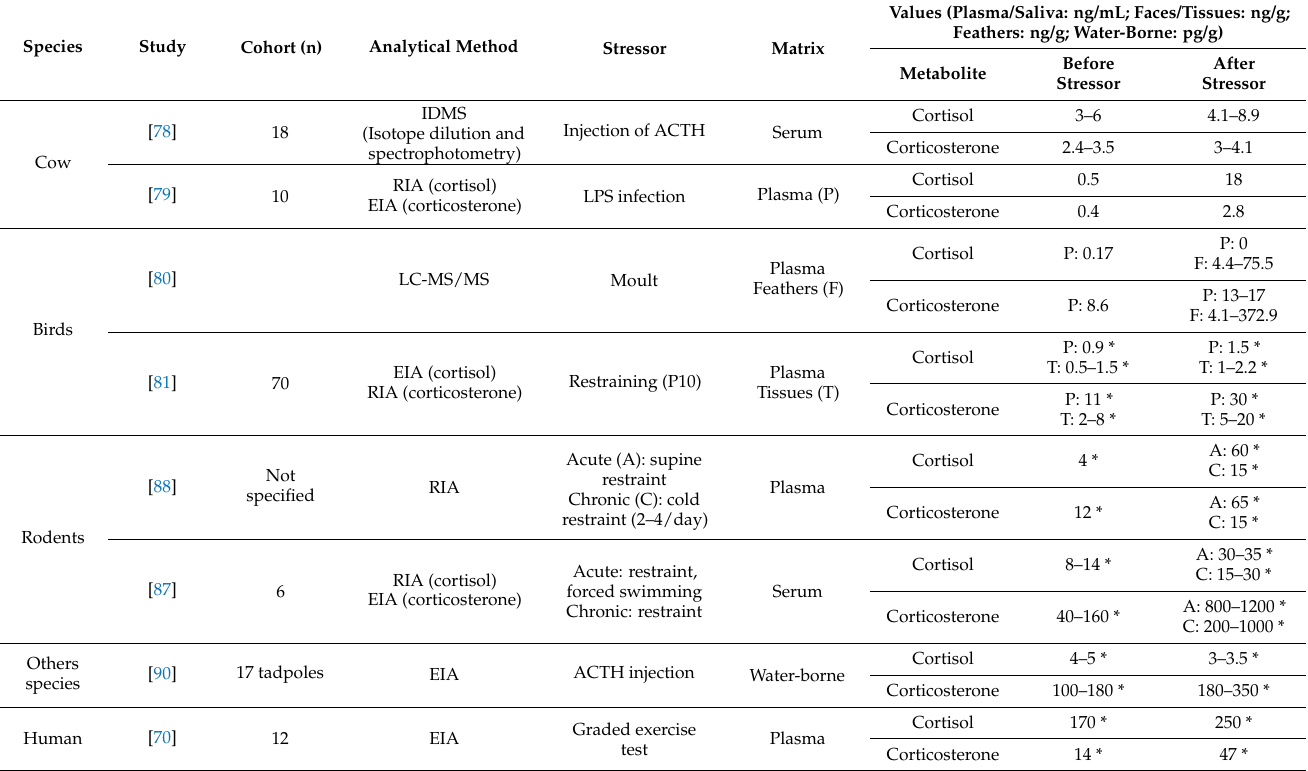
Table 4. Examples where cortisol and corticosterone were measured in combination after a